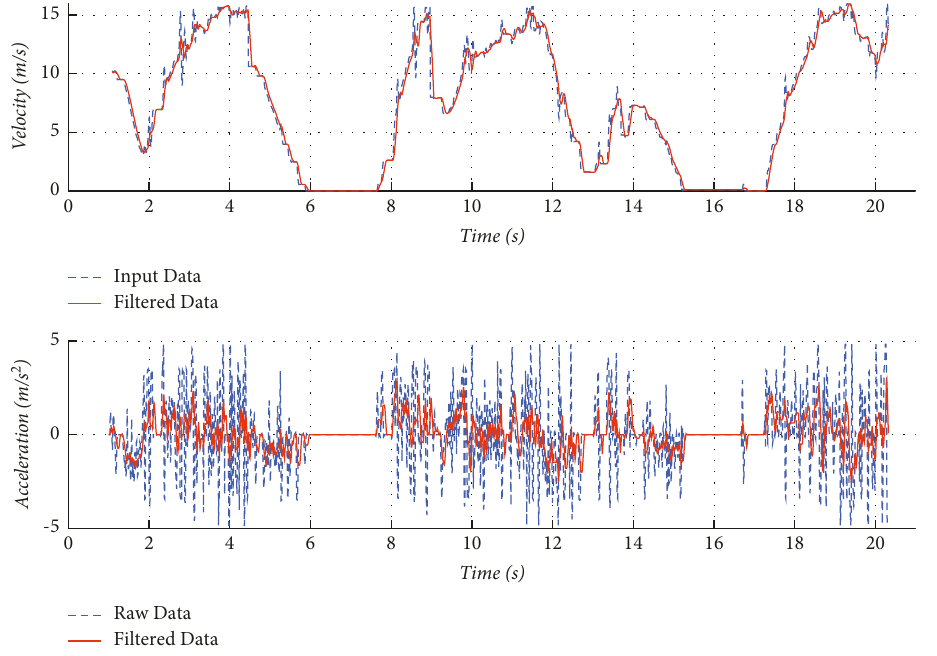
Figure 3: Comparison between the raw and filtered data. Table 1: Results of data filtering.